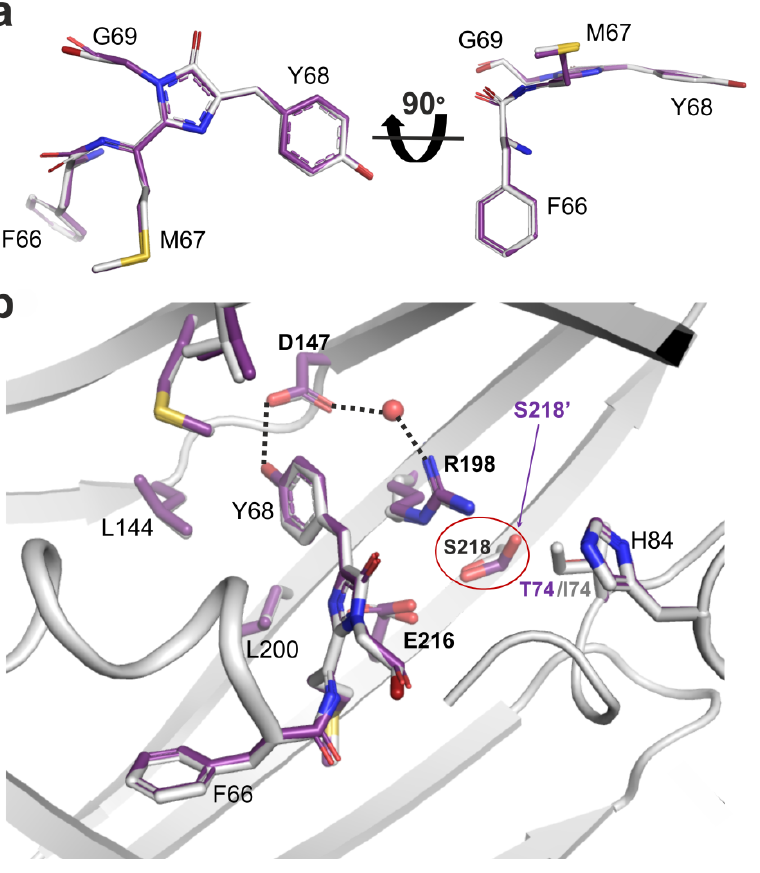
Figure 4. Structural comparison of the chromophores ( a ) and their immediate environments ( b ) for the LSSmScarlet2 (carbon atoms are colored magenta) and LSSmScarlet (PDB: 7OIN) (carbon atoms are colored gray) proteins. A water molecule (red sphere) provides hydrogen bonding (dashed lines) between residues D147 and R198 of LSSmScarlet2. D147 of LSSmScarlet2 forms a direct hydrogen bond (dashed line) with the Y68 residue. S218 in LSSmScarlet2 is highlighted by a red oval, and the alternative conformation of S218 (S218 ′ ) is indicated by an arrow. In Panel ( a ), the orientation of the chromophore on the right is rotated 90 ° around the horizontal axis with respect to that on the left. Table 2. Data collection and